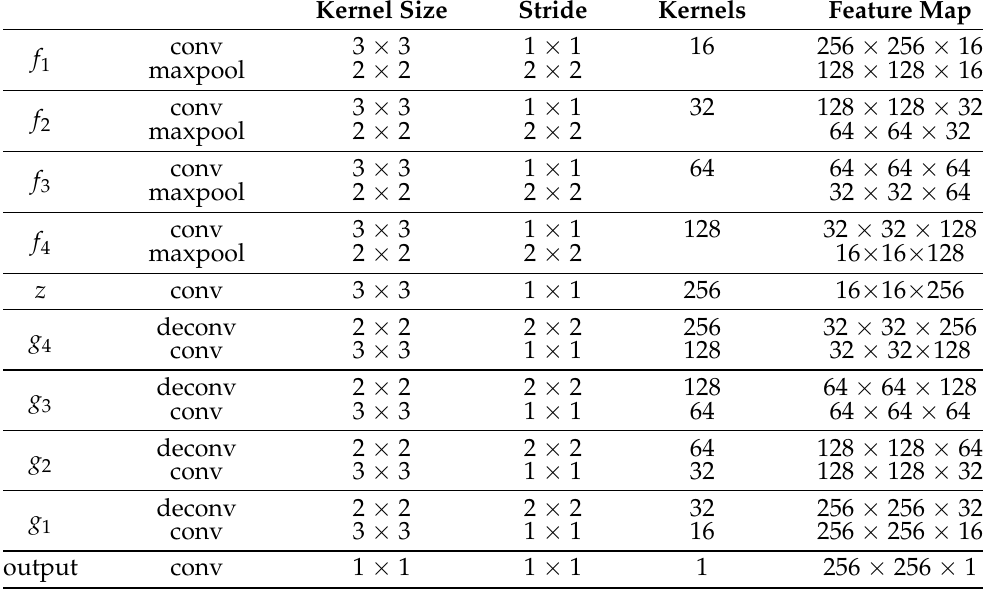
Table 2. Detailed architecture of the autoencoder network for lung segmentation, representing a kernel size, stride, the number of kernels, and size of output feature map of each